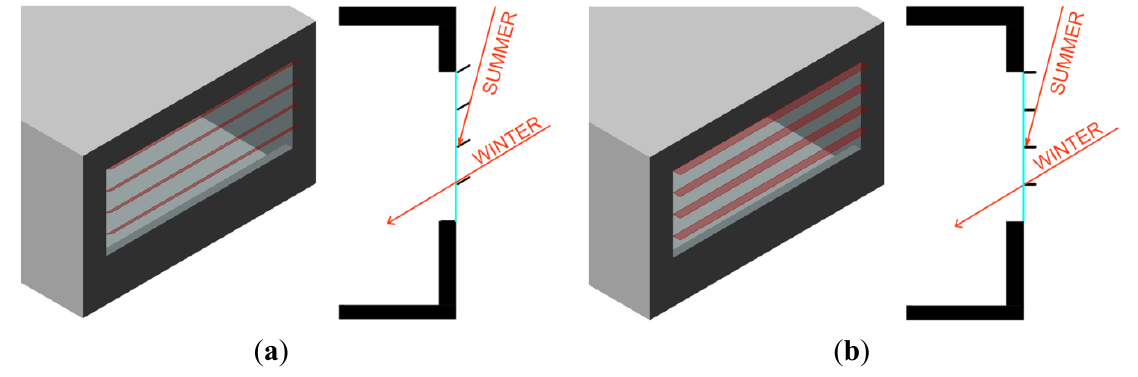
Figure 2. Traditional shading regarding building latitude. ( a ) T1; ( b )